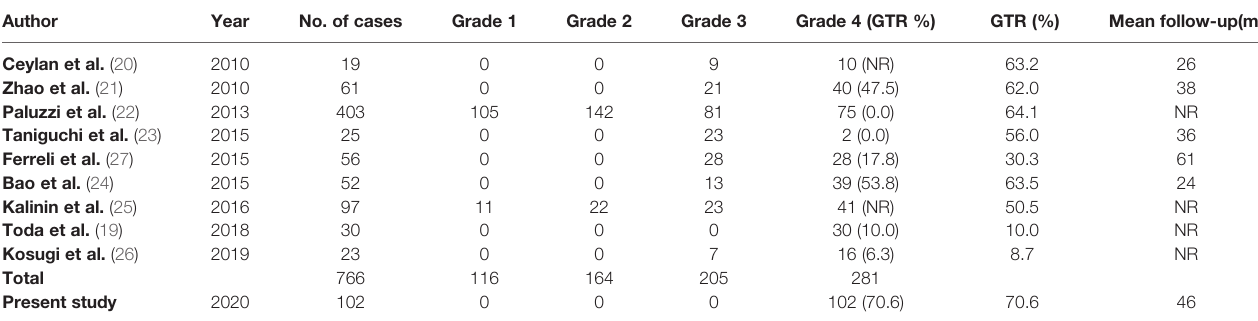
TABLE 8 | Comparison with similar studies of pituitary adenomas involving cavernous sinus published in the last